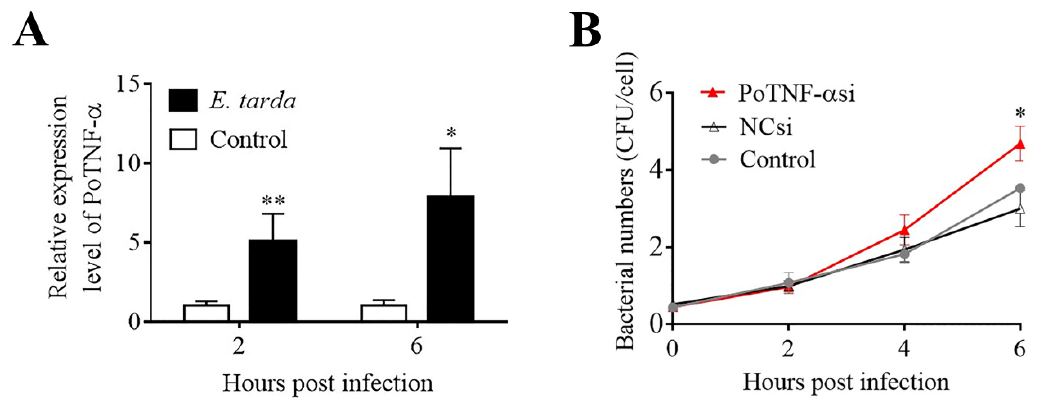
Figure 6. Effect of Japanese flounder TNF– α (PoTNF– α ) knockdown on Edwardsiella tarda infection. ( A ) Flounder FG–9307 cells were infected with E. tarda for 1 h, and the extracellular bacteria were killed by antibiotic treatment. The cells were then incubated for 2 and 6 h, and PoTNF– α expression was determined by qRT–PCR. ( B ) FG–9307 cells were pre-treated with or without (control) PoTNF– α si (a siRNA targeting PoTNF– α ) or NCsi (negative control siRNA) and infected with E. tarda for 1 h. The extracellular bacteria were killed as above. The cells were then incubated for different hours, and the intracellular bacterial number was determined. Values are the means of triplicate experiments and shown as mean ± SD. * p < 0.05; ** p < 0.01.